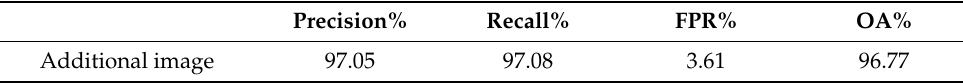
Table 5. Assessment of the detection results under additional